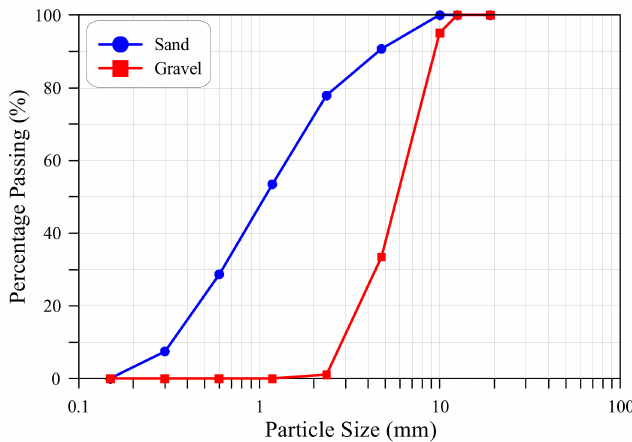
Figure 1. Grading of fine and coarse aggregates.